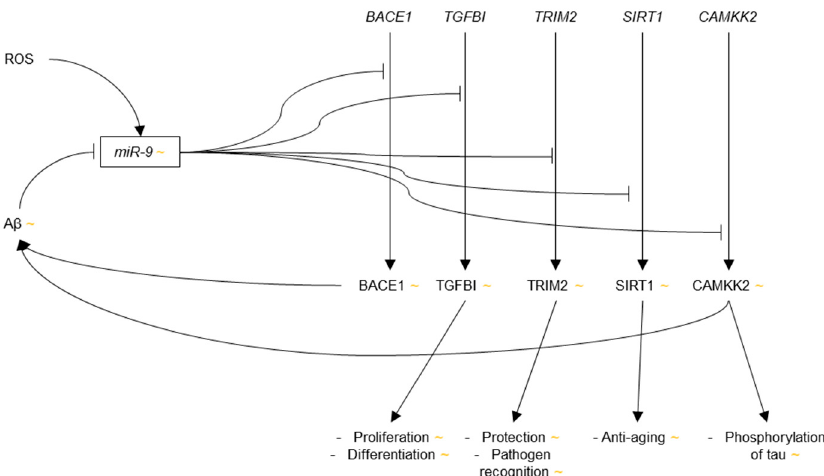
Figure 1. Regulation by miR-9. miR-9 inhibits the translation of β -site amyloid 1102 precursor protein cleaving enzyme 1 (BACE1), transforming growth factor, β -induced (TGFBI), tripartite motif-containing 2 (TRIM2), silent mating type information regulation 2 homolog 1 (SIRT1), and calcium/calmodulin-dependent protein kinase kinase 2 (CAMKK2). The debatable level of miR-9 expression in Alzheimer’s disease (AD) brain is indicated by the yellow tilde symbol (~), as are the hypothetical expression levels of the proteins regulated by miR-9 and their cellular effects. ROS: reactive oxygen species.